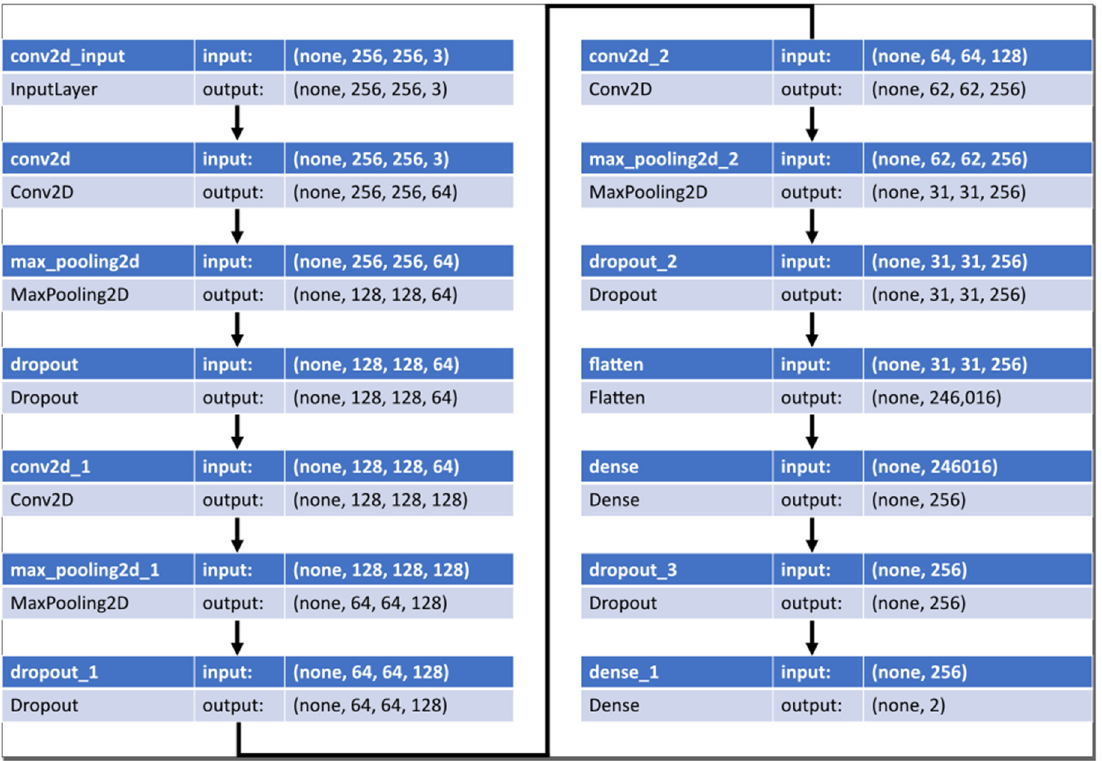
Figure 6. The structure of the CNN model.